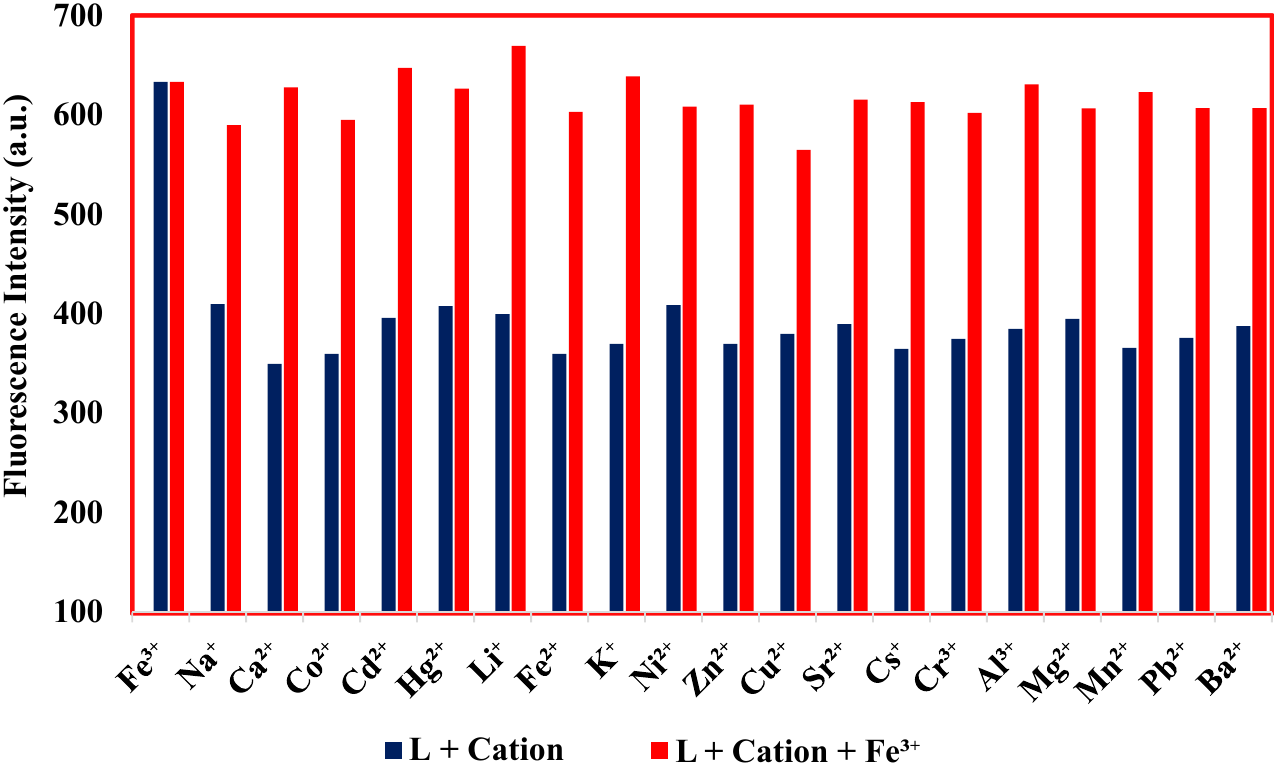
Figure 8. Selectivity of SBA-Pr-Is-TAP (3 mL H 2 O suspension, 0.2 g L − 1 ) for Fe 3+ (100 µ L, 1 × 10 − 4 M) using equal amounts of cations ( λ ex = 220 nm and λ em = 420 nm).